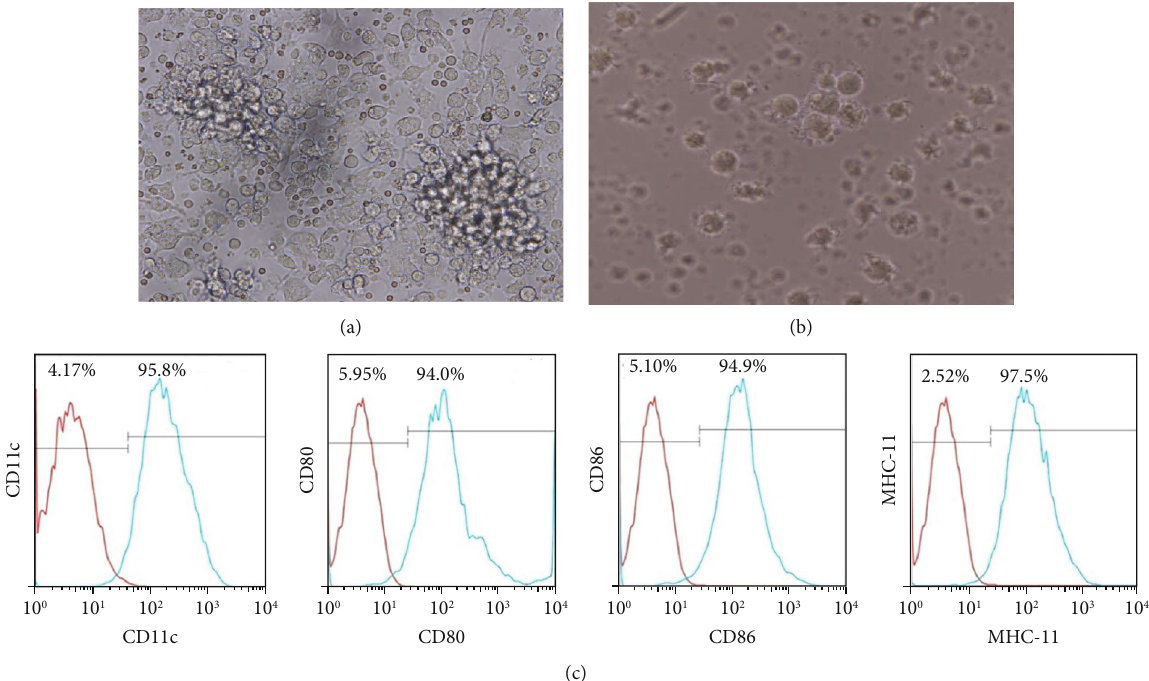
Figure 2: Dendritic cell isolation and characterization. (a and b) The morphology of the immature DCs and mature DCs (200x magni fi cation). (c) The expression of DC markers before and after maturation. The green lines represent the expression of LPS-induced DCs receptors; the red lines represent negative